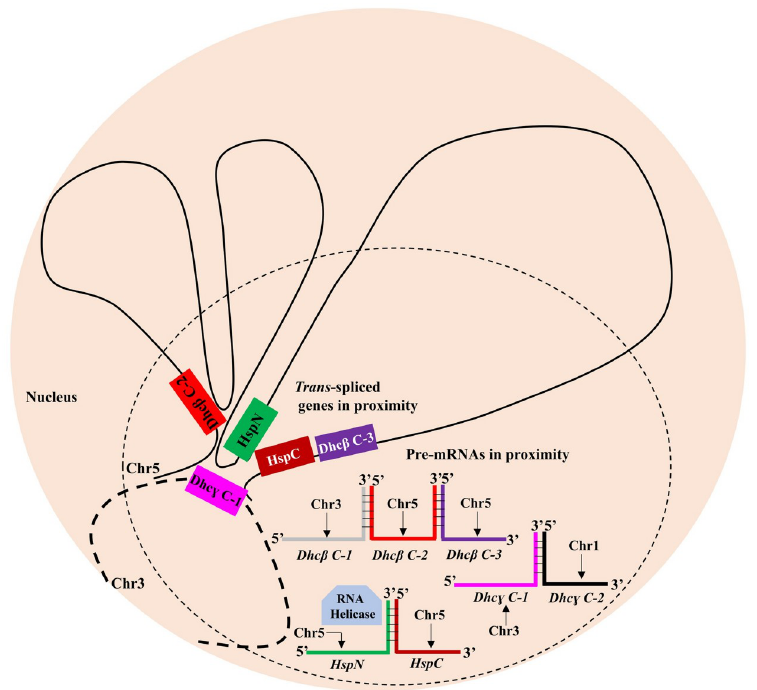
Fig 6. Model for mechanism of Giardia gene trans -splicing in vivo . Chromatin looping establishes long range contact between the trans -spliced genes in Giardia lamblia precisely between locus 2 and loci 6–11 in the vicinity of HspN and HspC ORFs; between locus 2 and locus B plus 3alt in the vicinity of HspN and Dhc β C-2 and locus 2 and locus G internal close to HspN and within Dhc ɣ C-1. The pre-mRNAs independently transcribed from the respective ORFs in proximity, thus would be in proximity to facilitate accurate trans -splicing of split genes aided by nuclear factors like RNA helicase.